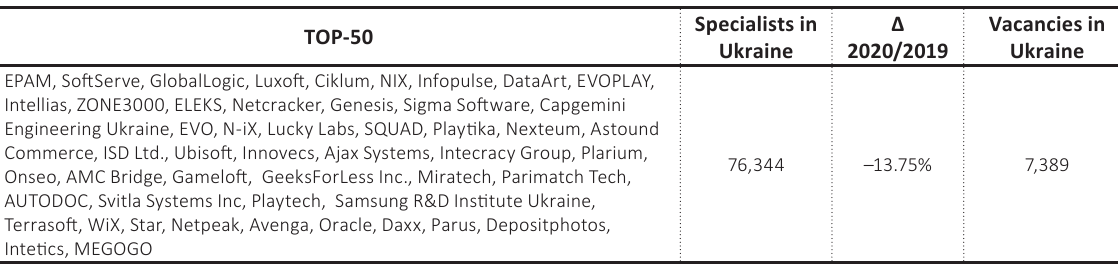
Table 1. TOP-50 largest IT companies in Ukraine